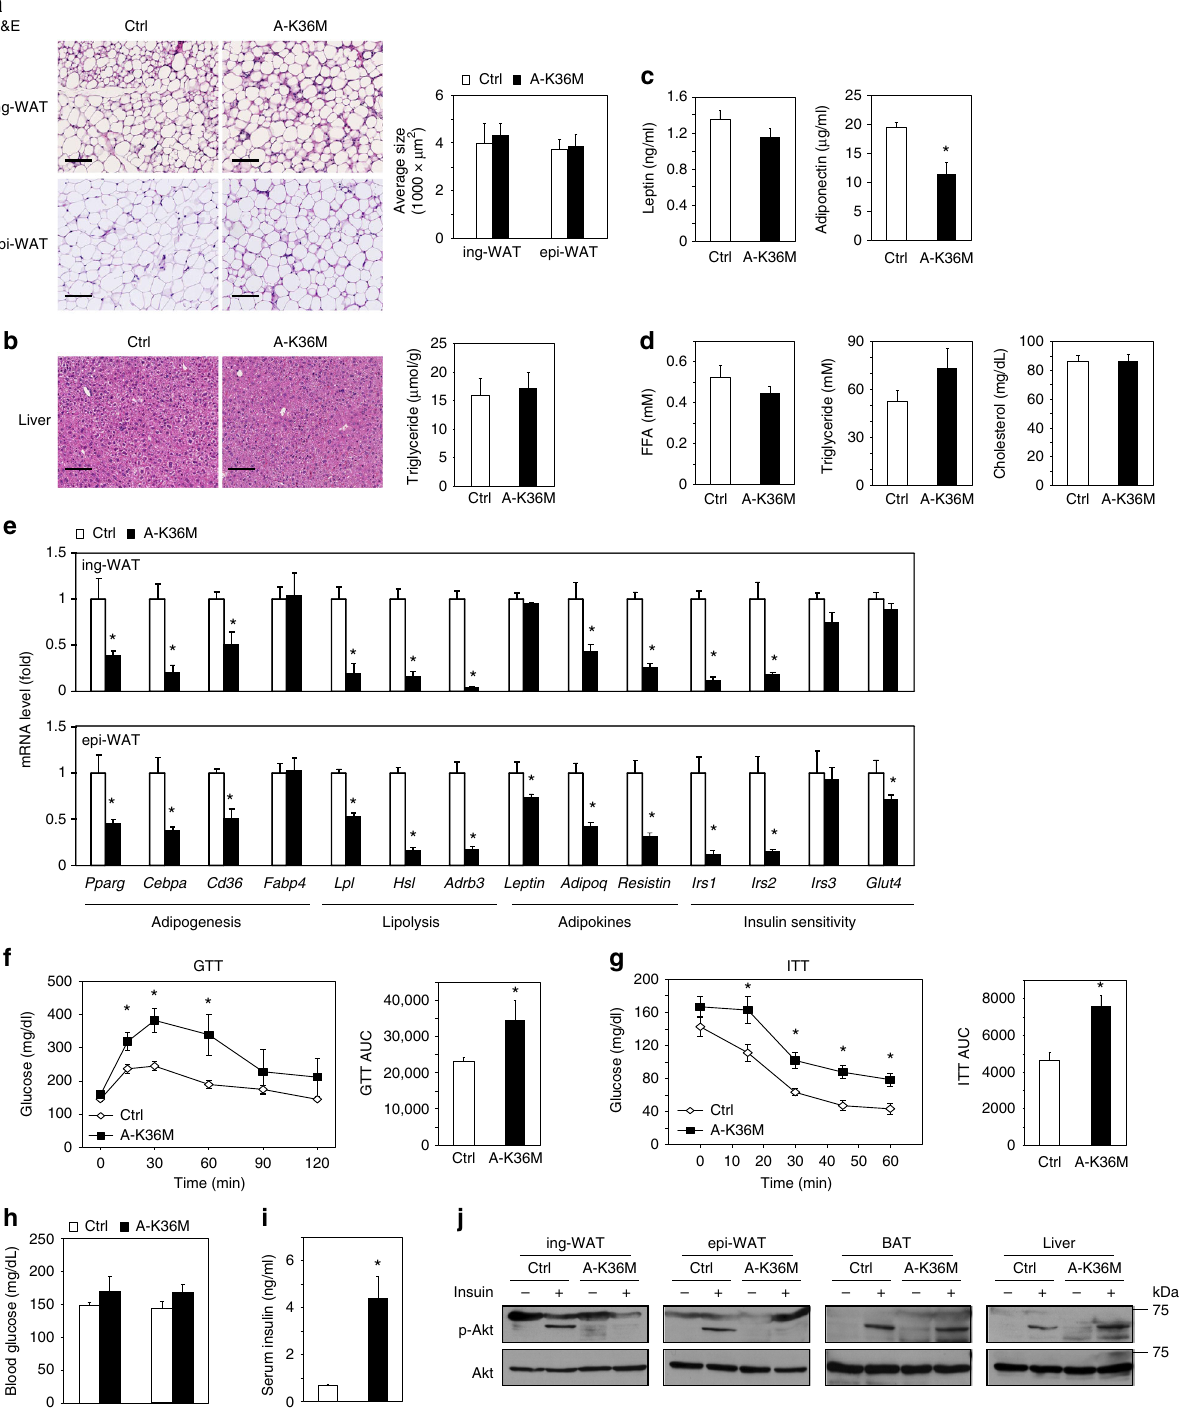
Fig. 6 Adipose-selective expression of H3.3K36M causes insulin resistance in WAT. Eight-week-old to 10-week-old male Ctrl and A-K36M mice ( n = 6 per group) were fed with regular diet. a H&E staining of ing-WAT (upper panels) and epi-WAT (lower panels). Scale bar = 100 µ m. Average sizes of adipocytes in ing-WAT and epi-WAT are shown on the right. Adipocyte size was calculated using ImageJ. b H&E staining of the liver. Scale bar = 100 µ m. Triglyceride content in the liver is shown on the right. c Serum leptin (left) and adiponectin (right) levels. d Serum levels of free fatty acid (FFA), triglyceride, and cholesterol. e qRT-PCR analysis of adipogenesis, lipolysis, insulin sensitivity, and adipokine genes in ing-WAT and epi-WAT. f Glucose tolerance test (GTT). Area under the curve (AUC) is shown on the right. g Insulin tolerance test (ITT). AUC is shown on the right. h Fed or fasted blood glucose levels. i Serum insulin levels in the random-fed status. j Western blot of phosphorylated Akt at Serine 473 (p-Akt) and total Akt in protein extracts of ing-WAT, epi-WAT, BAT, and liver. All values in Fig. 6 are presented as means ± SEM. Statistical comparison between groups was performed using Student ’ s t test. * p <